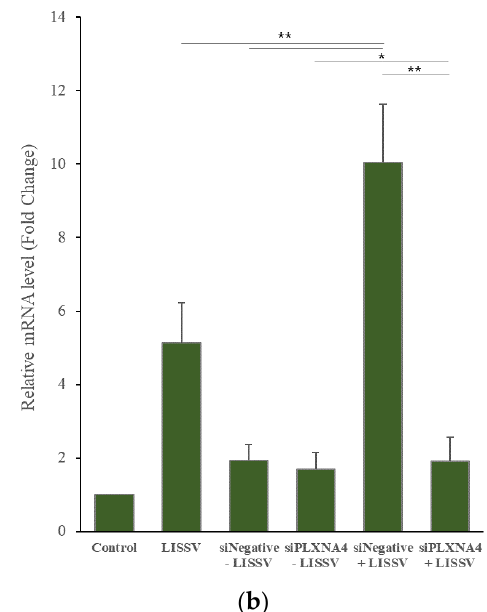
Figure 8. PLXNA4 gene silencing using small interfering RNA transfection methods in human umbilical-cord-derived mesenchymal stem cells. Cells were harvested 4 days after low-intensity sub-sonic vibration treatment. ( a ) Morphology of each sample: A. Control; B. low-intensity sub- sonic vibration (LISSV); C. siNegative duplex 90 nmol without ( − ) LISSV; D. siPLXNA4 duplex 90 nmol without ( − ) LISSV; E. siNegative duplex with (+) LISSV; F. siPLXNA4 duplex with (+) LISSV. Original magnification 40×. ( b ) Fold change in the expression PLXNA4 determined using real-time polymerase chain reaction analysis. Column heights correspond to mean values and error bars to standard deviations ( n = 3). * p < 0.05, ** p < 0.01.